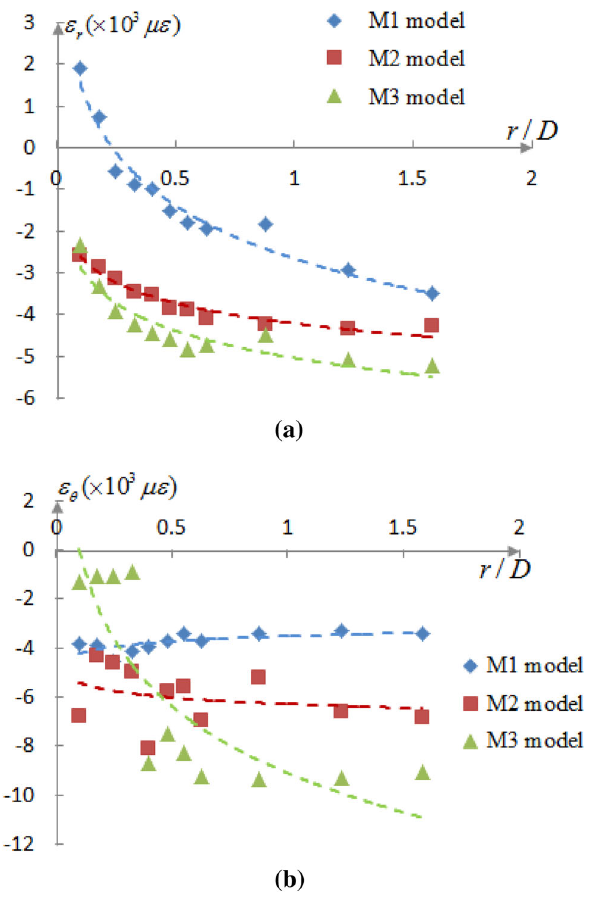
Fig. 11 Comparative analysis of the a radial and b circumferential strains at the top of the vaults for the three models after excavation